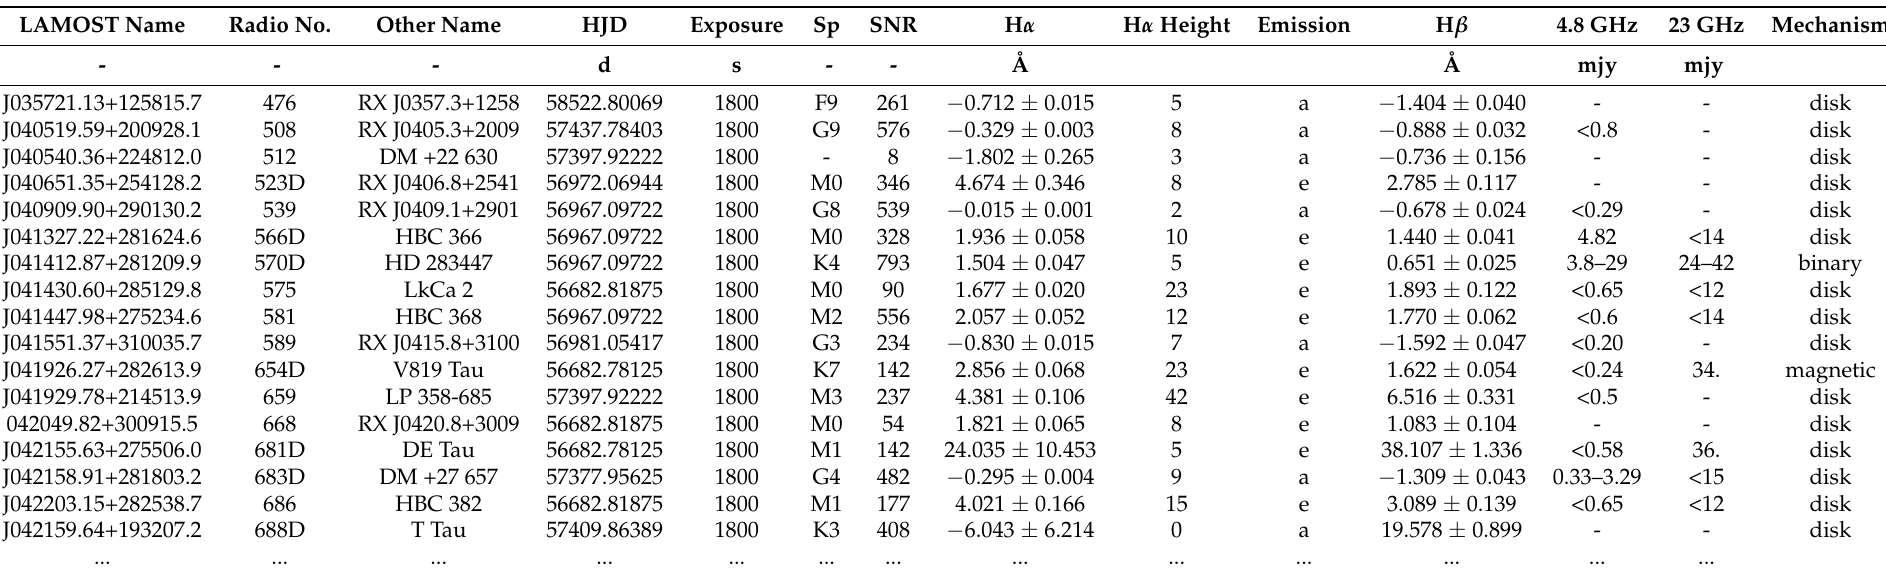
Table 1. Parameters of radio stars observed in LAMOST low resolution spectral survey along with their H α